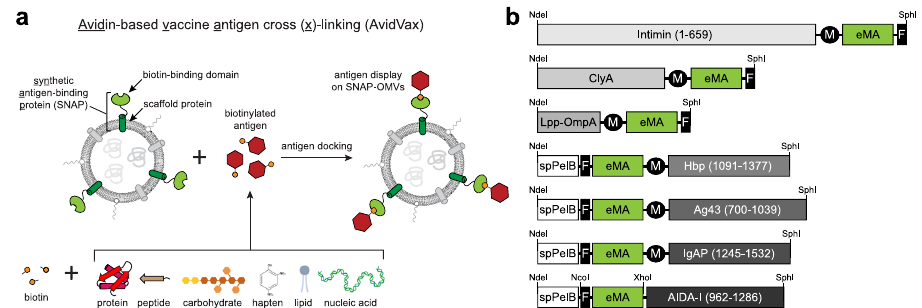
Fig. 1 | A modular platform for rapid self-assembly of OMV-based vaccine candidates. a Schematic of AvidVax technology whereby ready-made OMVs dis- playingasyntheticantigenreceptor(SNAP-OMVs)areremodeledwithbiotinylated antigens-of-interest. Using AvidVax, the surface of SNAP-OMVs can be remodeled withvirtuallyanybiomoleculethatisamenabletobiotinylationincludingpeptides, proteins, carbohydrates, glycolipids, glycoproteins, haptens, lipids, and nucleic